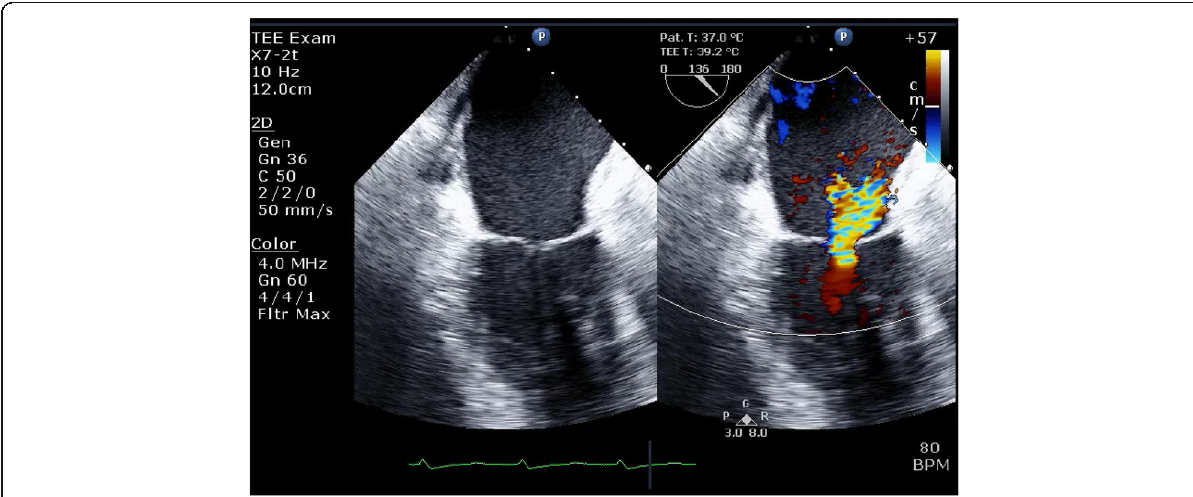
Fig. 2 Intraoperative transesophageal echocardiography images after aortic valve surgery, showing a color Doppler image showing severe